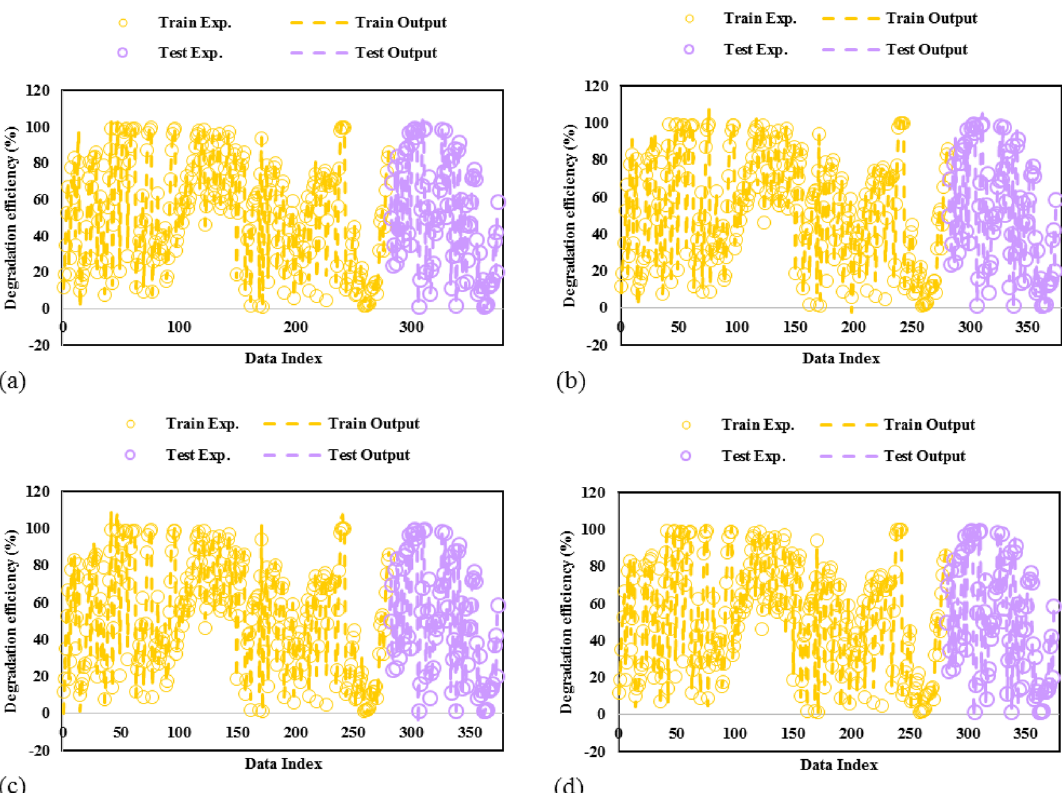
Figure 3. Comparison of actual and predicted values for GPR model with kernel function of (a) matern, (b) exponential, (c) squared exponential, (d) rational